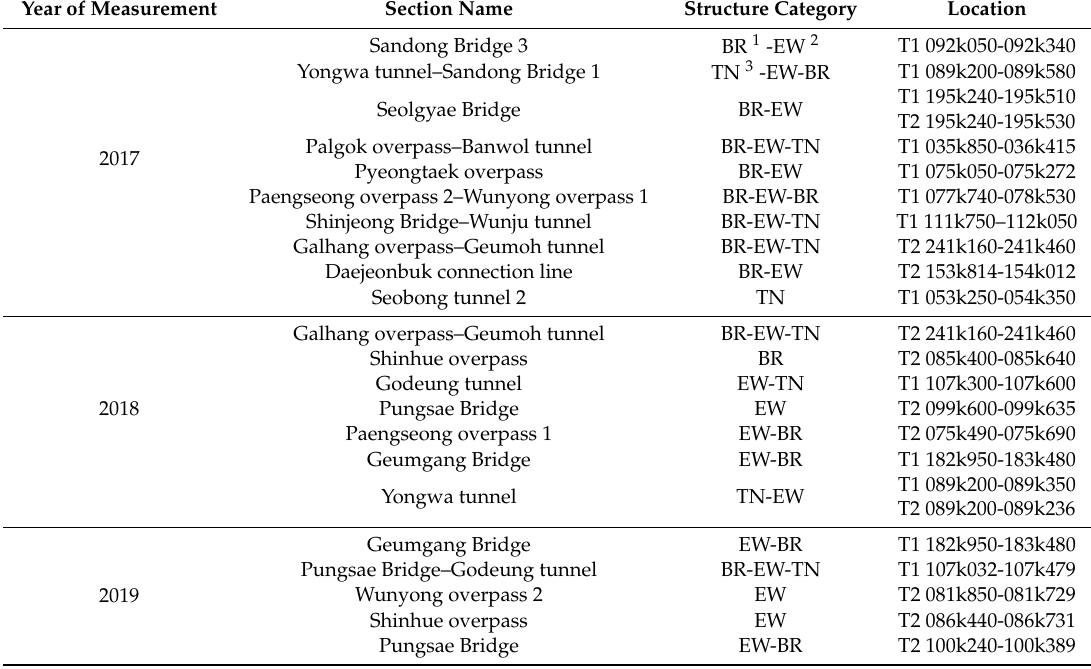
Table 1. Details of field